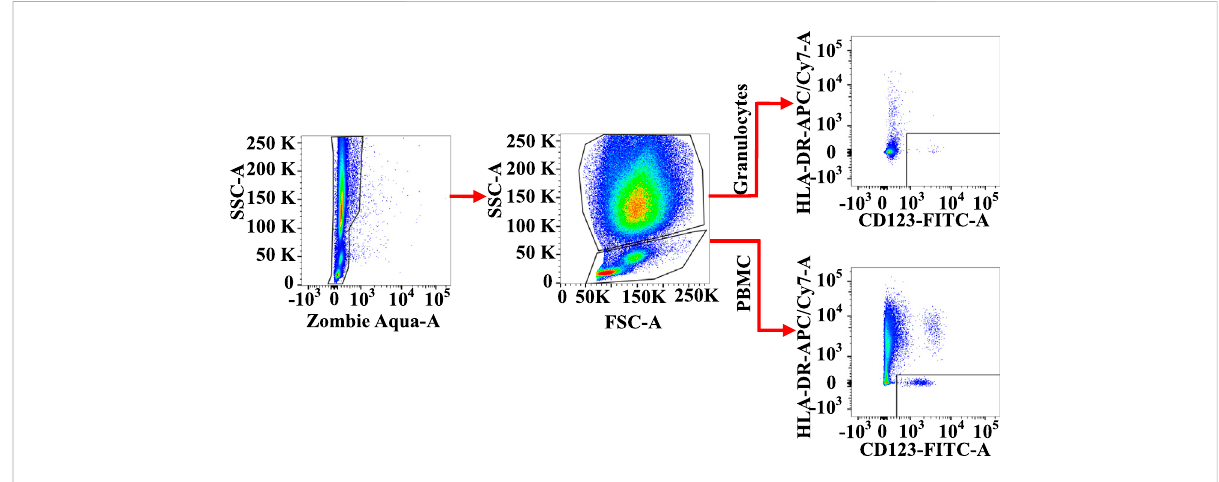
FIGURE 1 Gating strategies for CD123+HLA-DR − cells in both granulocyte and peripheral blood mononuclear cell (PBMC)